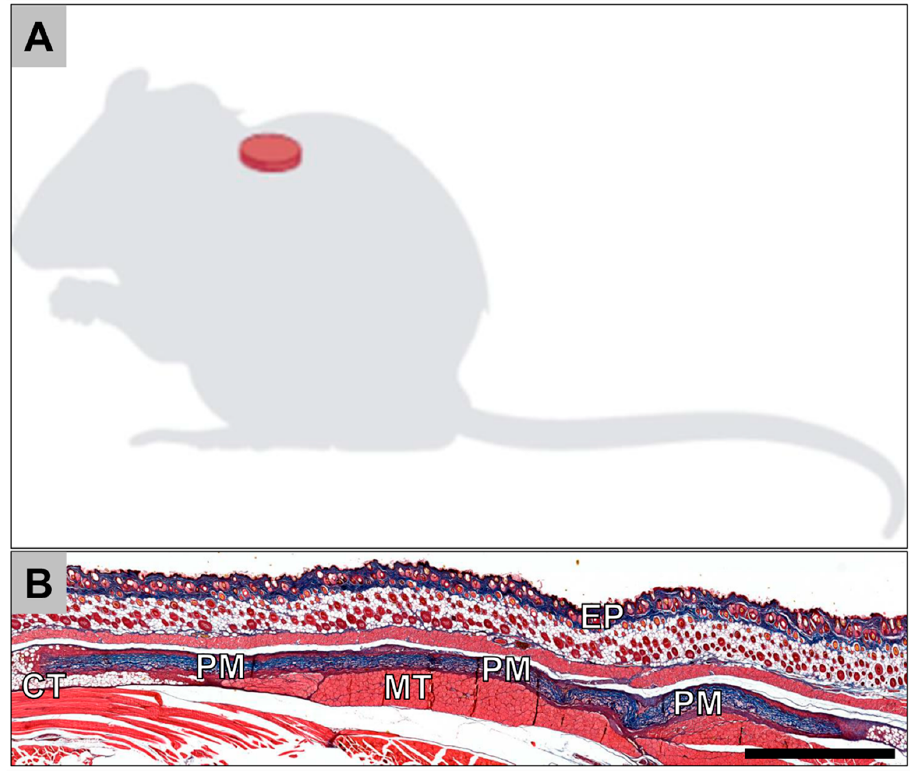
Figure 1. ( A ) Schematic image of the implantation site. ( B ) Overview of a subcutaneous implantation site of the porcine collagen membrane (PM) at day 30 postimplantation. CT = connective tissue; EP = epidermis (Azan-staining, “total scan”, 100 × magnification, scalebar = 1 mm).